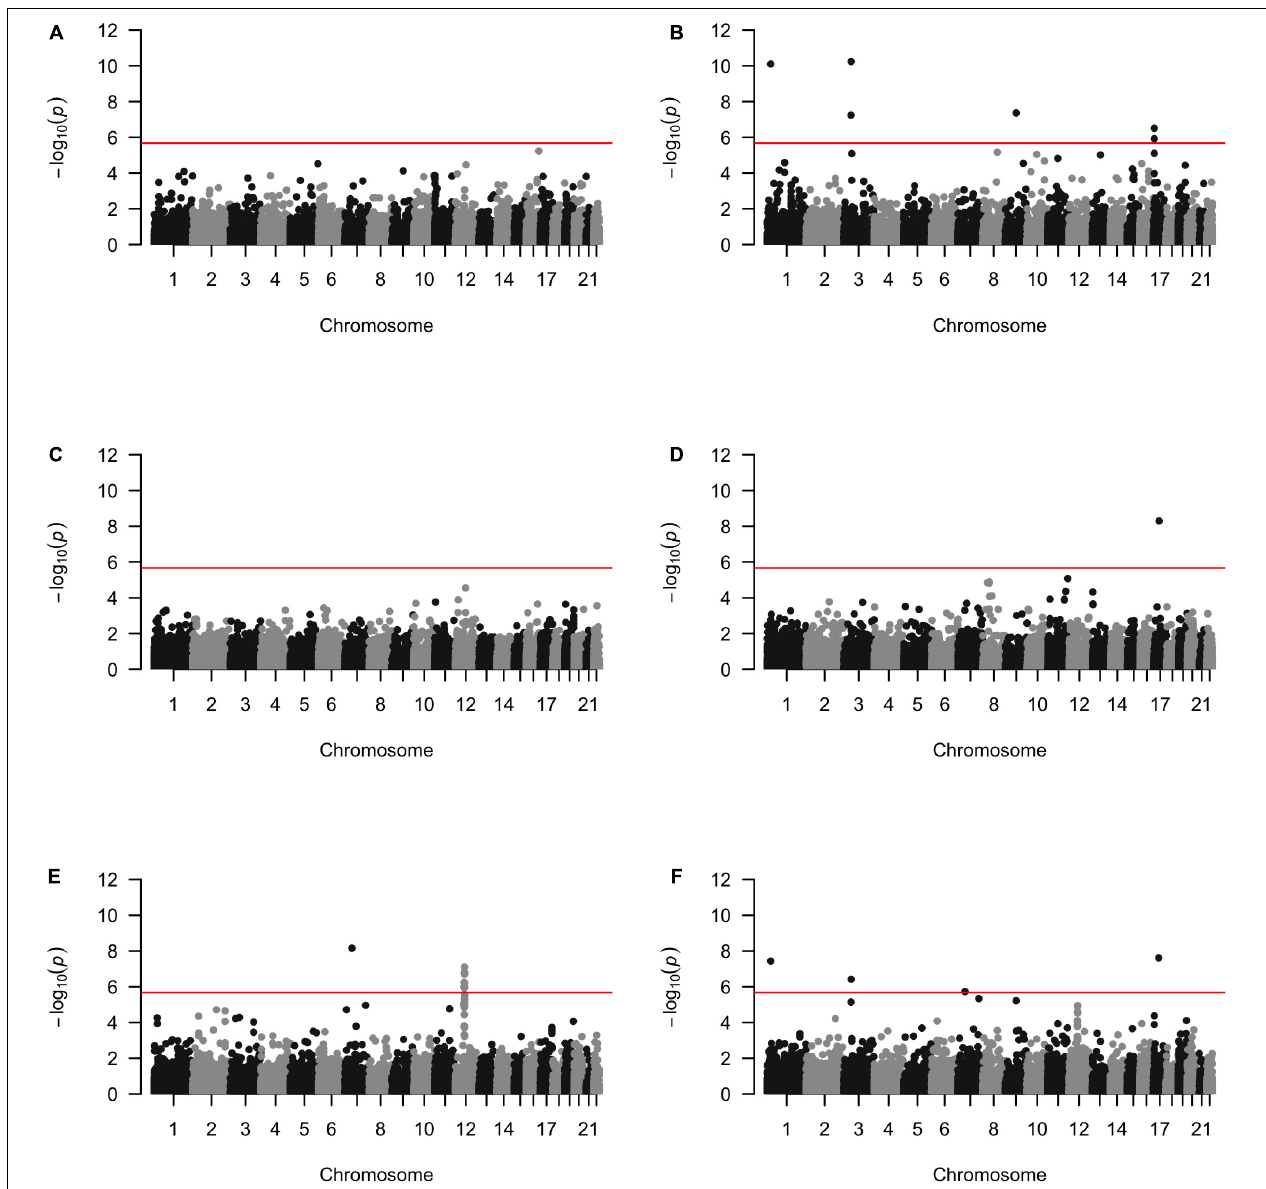
FIGURE 2 | The Manhattan plots by rare variants analysis in each population (A) Affymetrix. (B) Illumina. (C) OmniExpress. (D) OncoArray. (E) HumanCore. (F)